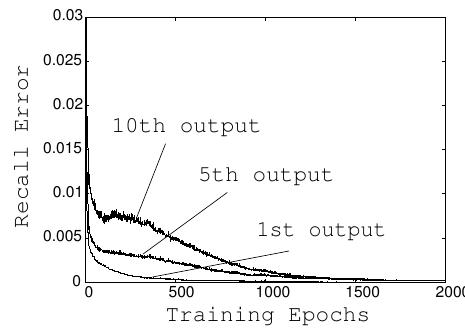
Figure 7: Recall errors during training of motion LSTM